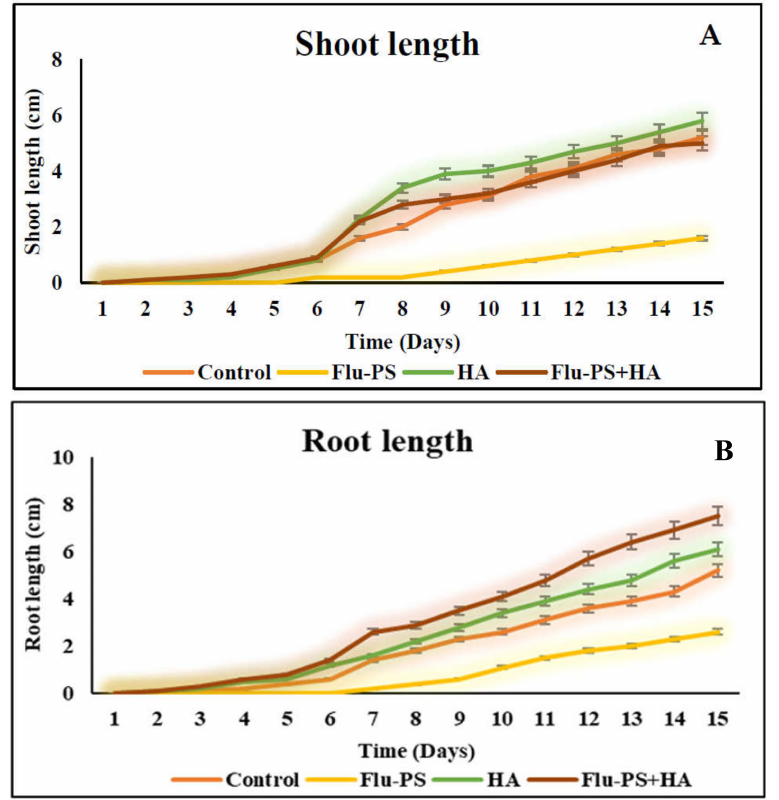
Figure 7. Measurements of the shoot and root lengths are shown in this line graph. ( A ) represents shoot length and ( B ) represents root length in Solanum lycopersicum (Control, Flu − PS, HA and Flu −